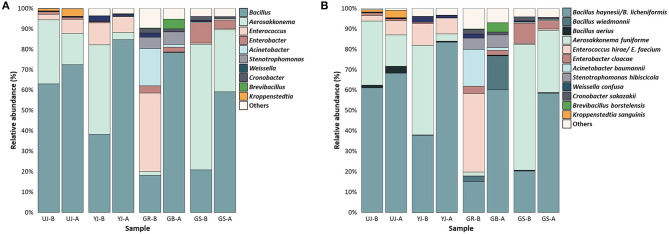
Bacterial composition in the gochujang samples before and after fermentation. Data portray (A) genus and (B) species level of 16S rRNA gene sequences. The “others” are composed of the genera or species with a prevalence of <0.5% of the total reads in each (all) sample. “-B” and “-A” mean before and after fermentation, respectively.